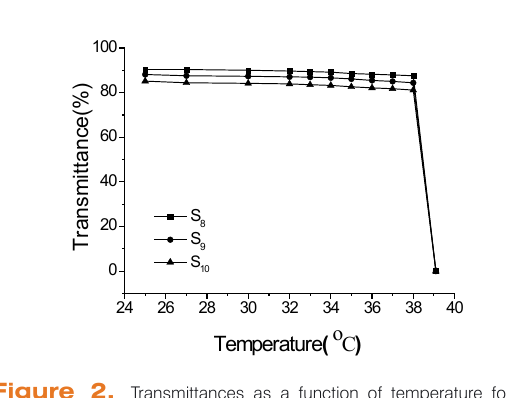
Figure 2. Transmittances as a function of temperature for the P(NIPAAm-co-Am) hydrogels with different content of cross-linker.